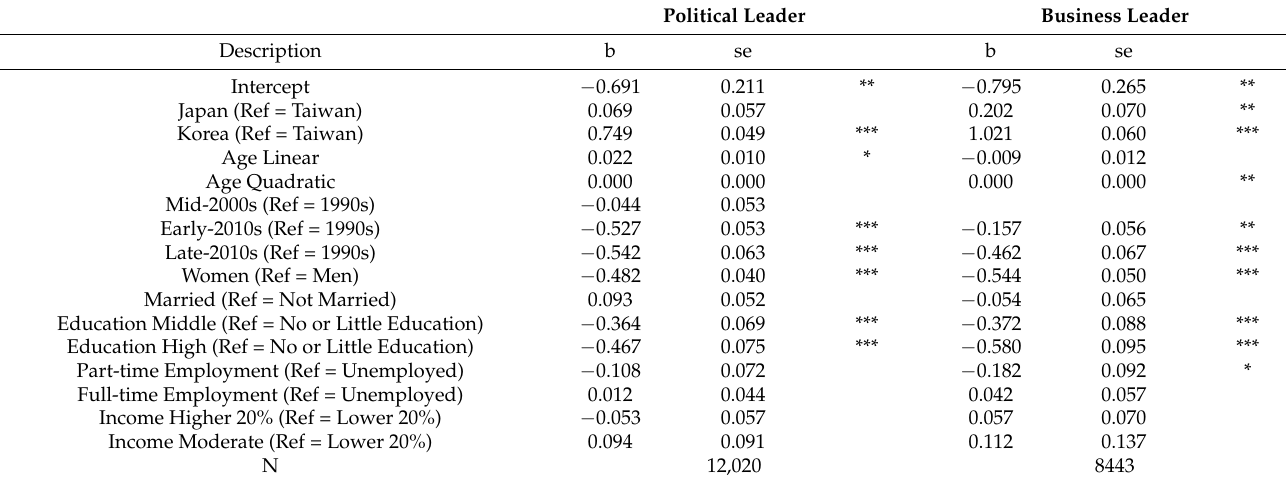
Figure 2. Gender and education effects on attitudes toward women business leadership in three Asian countries, the WVS. Note: * p < 0.05; ** p < 0.01; *** p < 0.001. Figure presents average marginal effects of each factor based on logistic regression models. Positive estimates indicate a higher likelihood of supporting traditional attitudes that favor men over women in business leadership. ( a ) shows the main effect of country; ( b ) shows the main effect of gender in each country; ( c ) shows the main effect of education in each country; ( d ) shows the interaction between education and gender in Taiwan; ( e ) shows the interaction between education and gender in Japan; ( f ) shows the interaction between education and gender in Korea. Table 4. Fixed-effect multilevel logistic model results, the WVS